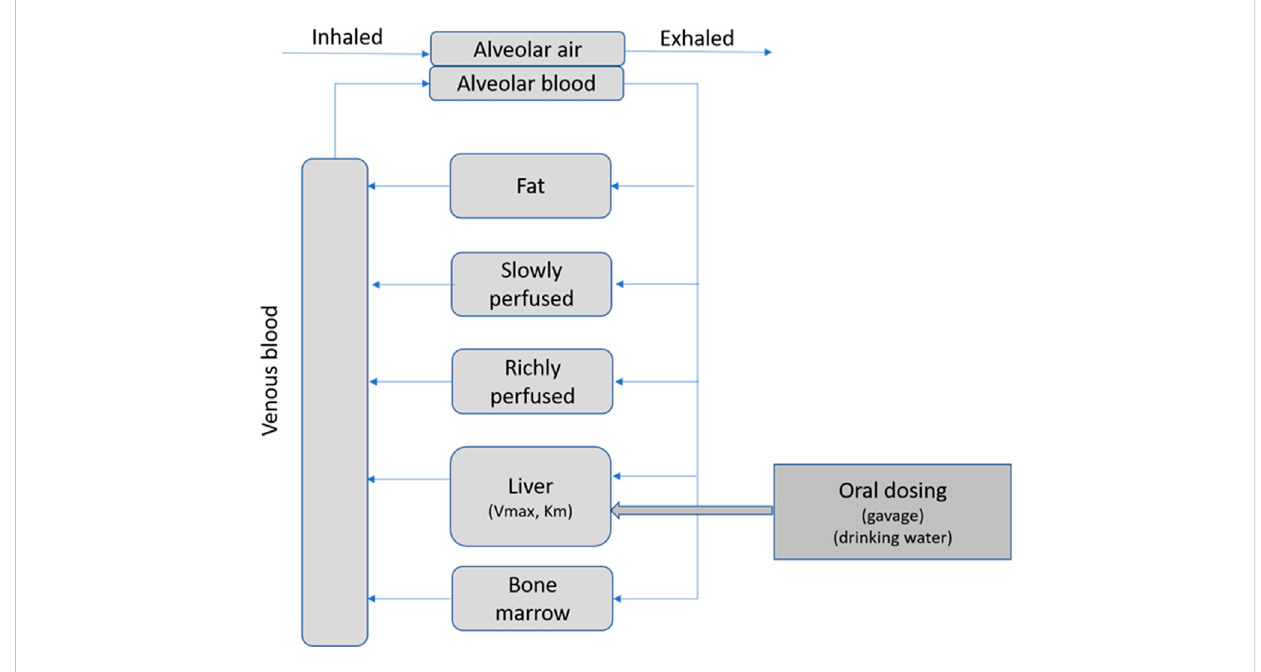
FIGURE 1 PBPK model for 3-CAA.